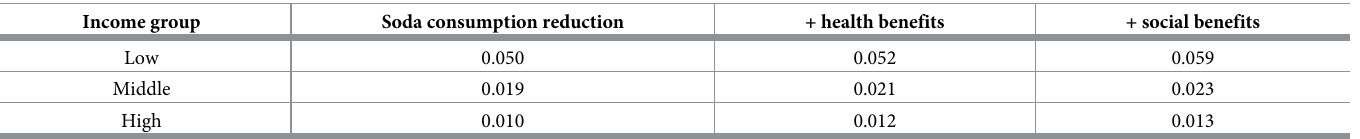
Table 4. Ratio of WTP relative to income, by household income group and WTP